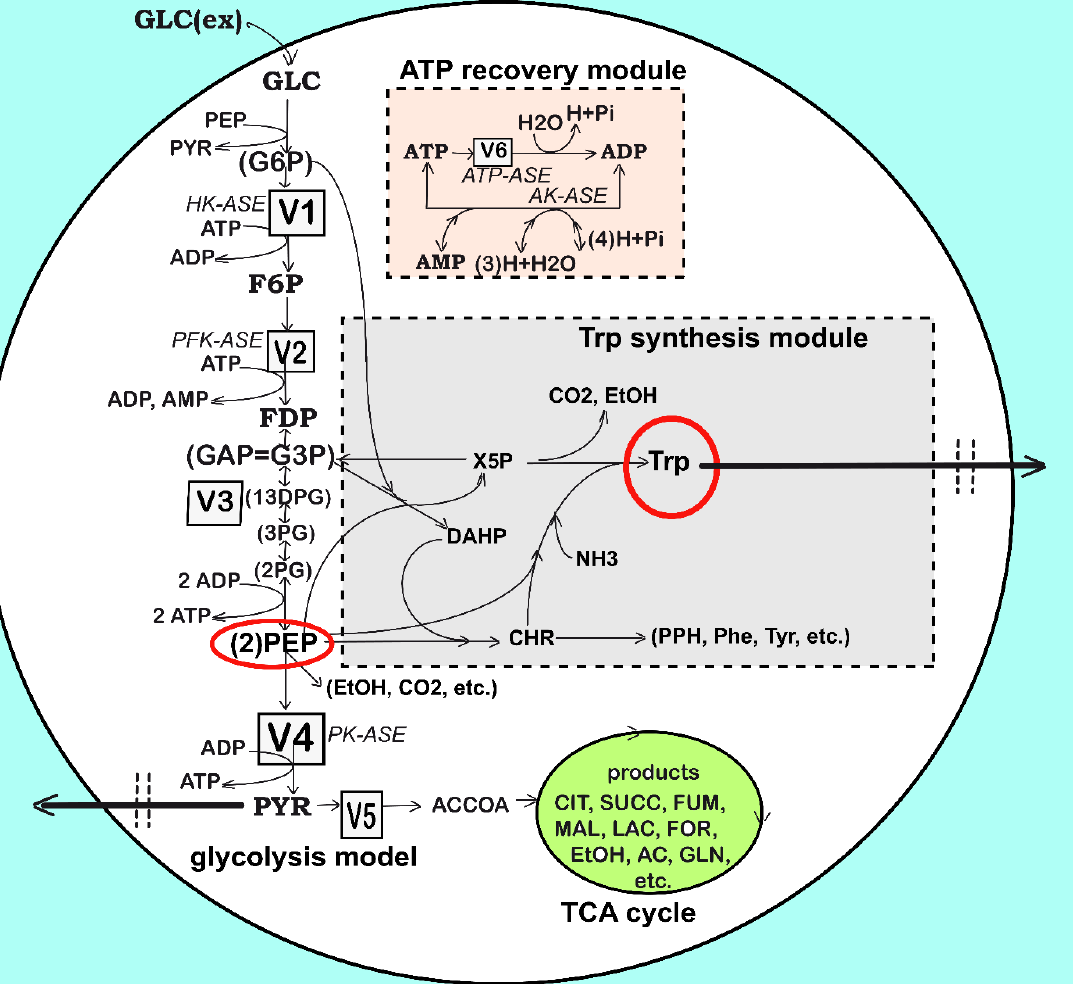
Figure 3. Simplified structured reaction pathway in E. coli for glycolysis (after Maria [48]), and for the TRP synthesis (the gray area) (after Maria et al. [35,37,48]). This reaction pathway was used by Maria et al. [34,37] to derive a TRP synthesis kinetic model. Connection of the TRP synthesis to glycolysis is realized through the PEP node [33,37]. The modular model structure also includes the synthesis of adenosine cometabolites ATP, ADP, and AMP, as part of the ATP recovery system (the pink rectangle in the figure). Notations: GLC(ex)= glucose in the cell environment. Species abbreviations are given in the abbreviations list. Species in parenthesis are not explicitly included in the glycolysis model. Italic letters denote the enzymes. Squares include notations of enzymatic reactions V1–V6 included in the glycolysis model (Table 2; Table 3). Adapted from [48] with the courtesy of CABEQ Jl., and completed according to the Maria [35] kinetic model.